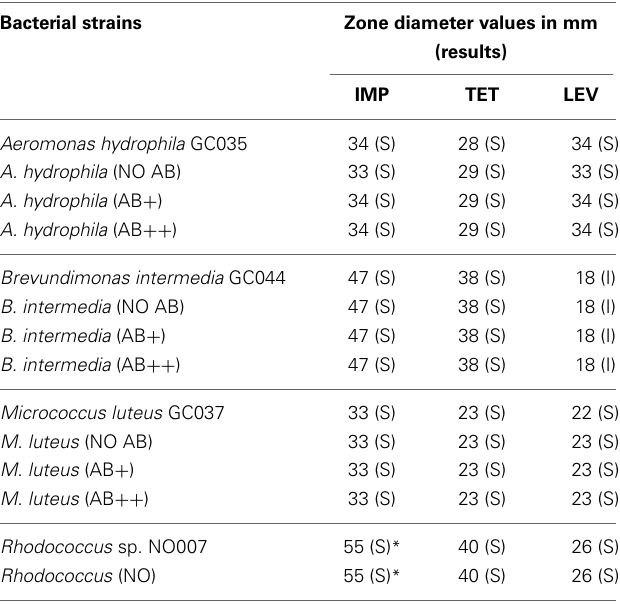
Table 1 | Results of antimicrobial susceptibility tests by disk diffusion